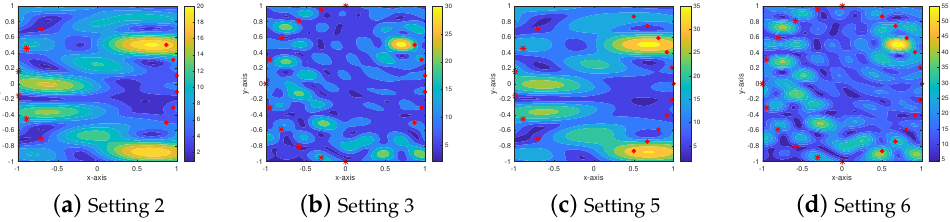
Figure 8. (Example 4) maps of F OSM ( r ) . The red-colored marks ◦ and ∗ denote the incident and observation directions,